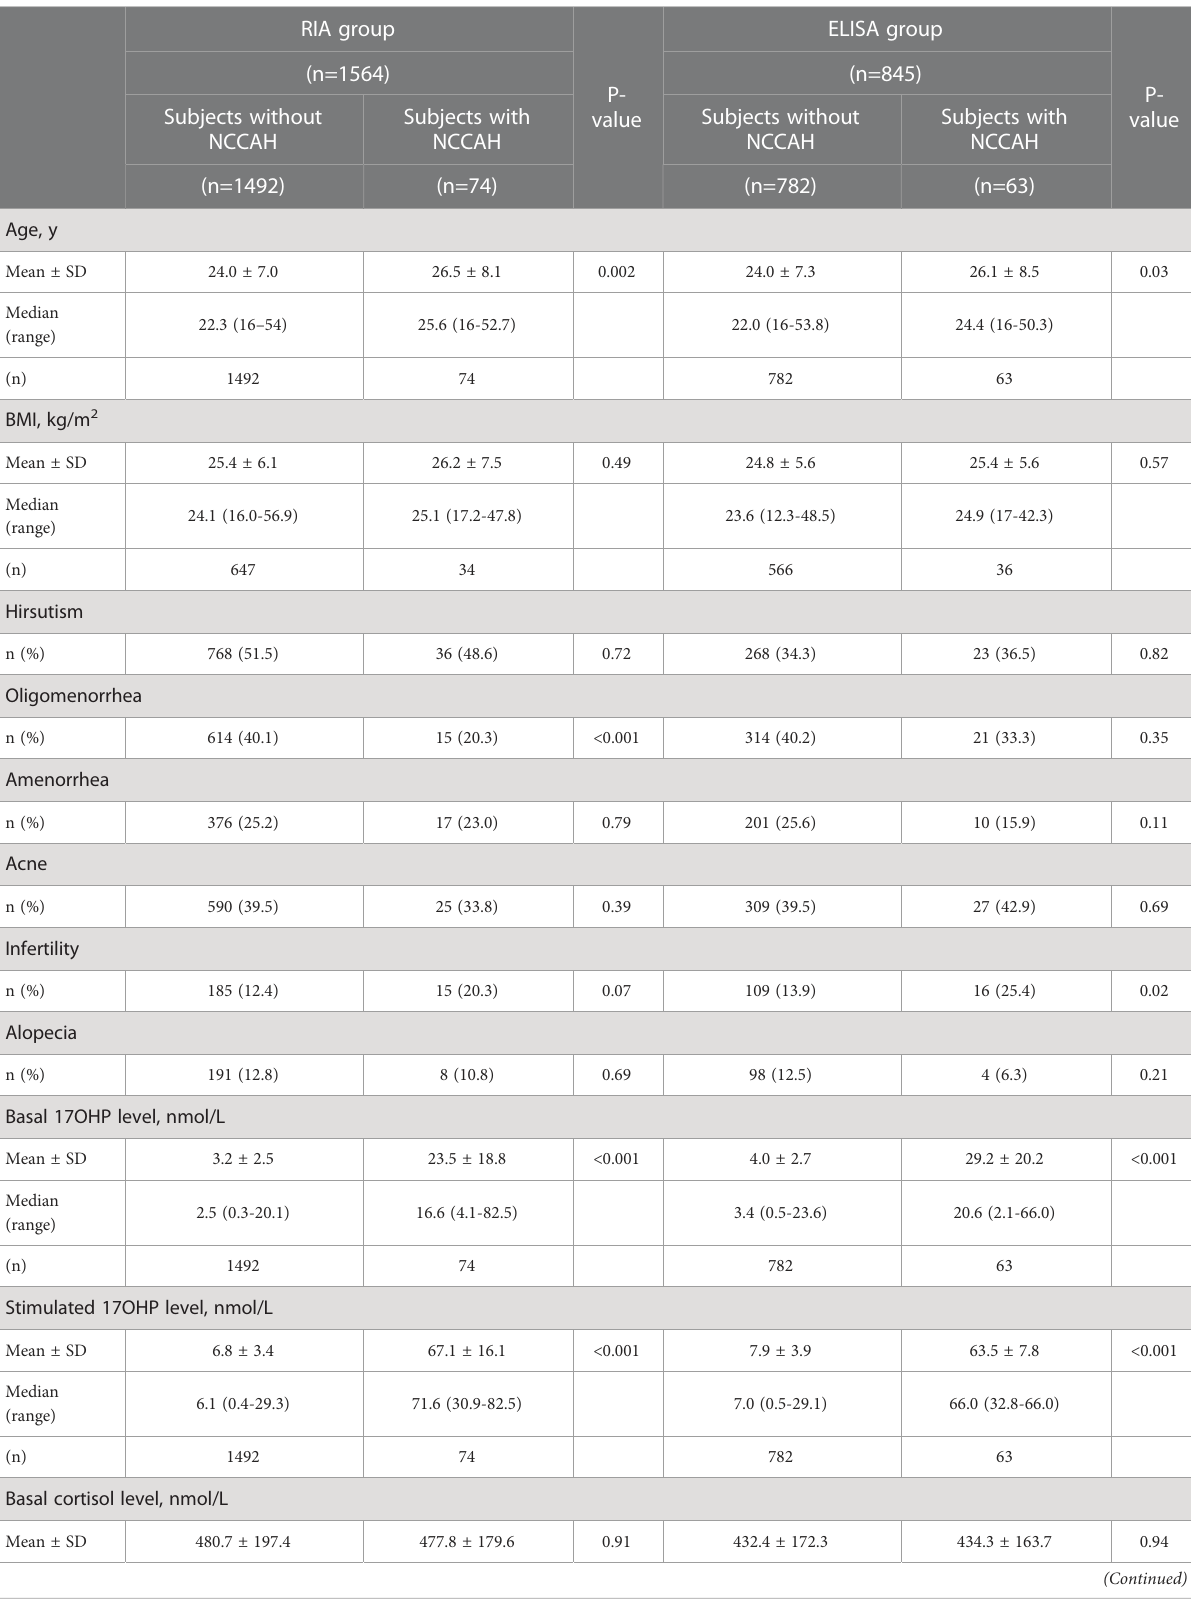
TABLE 4 Comparison of clinical and biochemical characteristics between women with and without NCCAH in the RIA and the ELISA